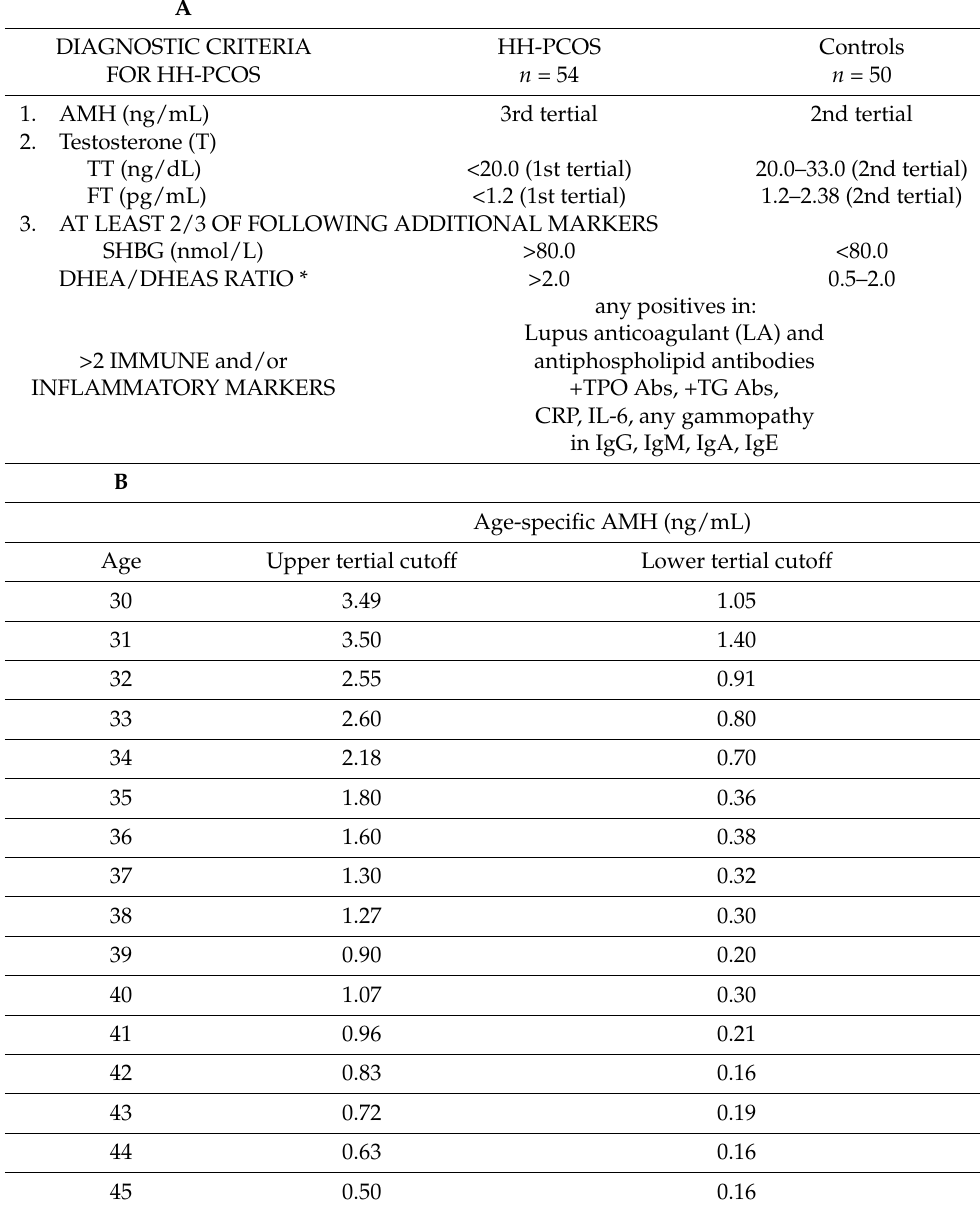
Table 2. ( A ): Selection criteria for HH-PCOS and control patients . * Because the hypoandrogenism is of adrenal origin, DHEAS is usually significantly lower than DHEA. For patient selection in this study, at least a ration of 2.0 was required to qualify as a HH-PCOS patient. Except for the LA, which is expected to be negative, all other immune tests have normal ranges. A result was considered positive if this normal range was exceeded. ( B ): Age-specific AMH cut-offs defining upper and lower tertial, with 2nd tertial in